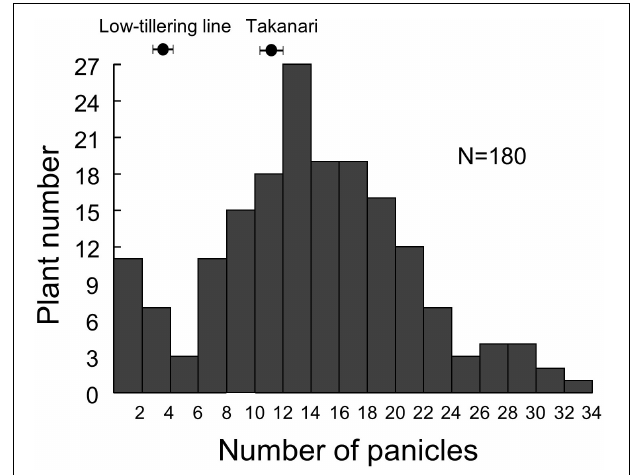
FIGURE 4 | Frequency distribution of panicle number in F 2 population derived from a cross between low-tillering plants and “Takanari.”